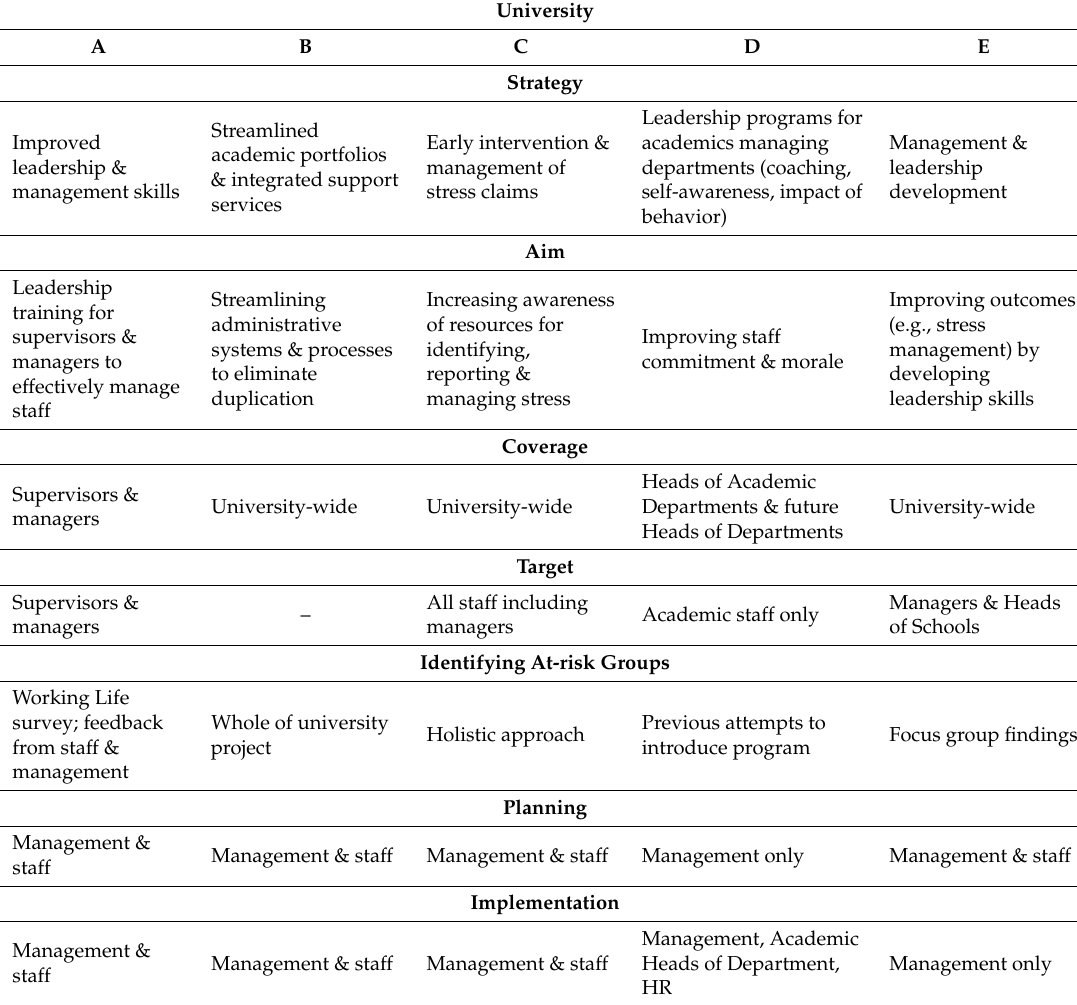
Table 2. Priority Strategies: Aims, Coverage, Targets, Planning and Implementation